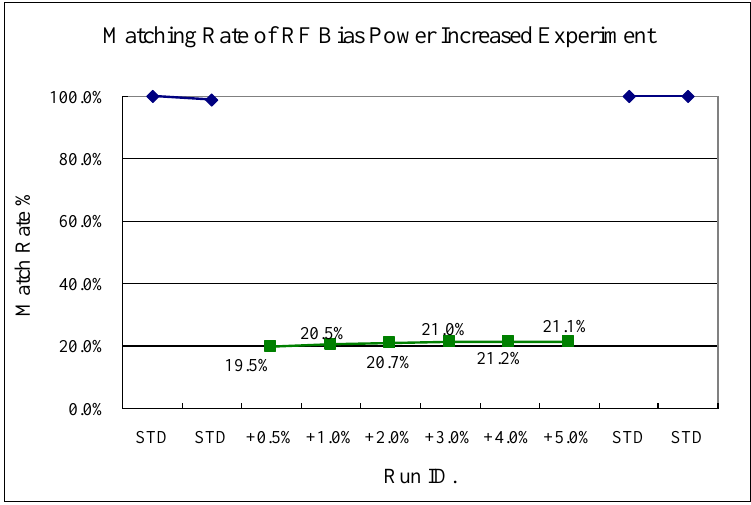
Figure 16. Experiment 7, bias RF power variance tested from 70.35 to 73.35 W. (STD = 70 W). Matching Rate of RF Bias Power Increased